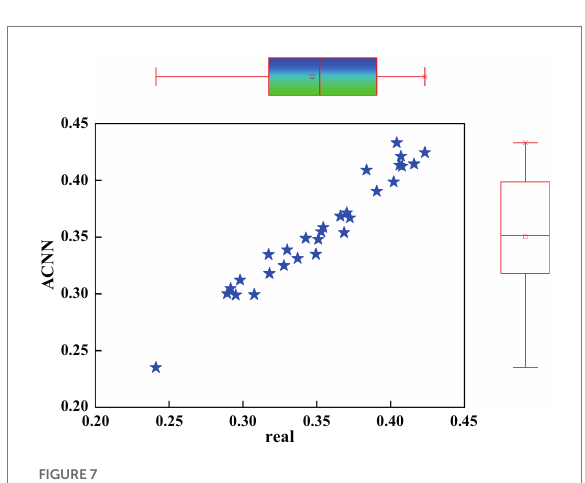
FIGURE 7 Predicted value distributions of people’s preferences in mental health and literature.